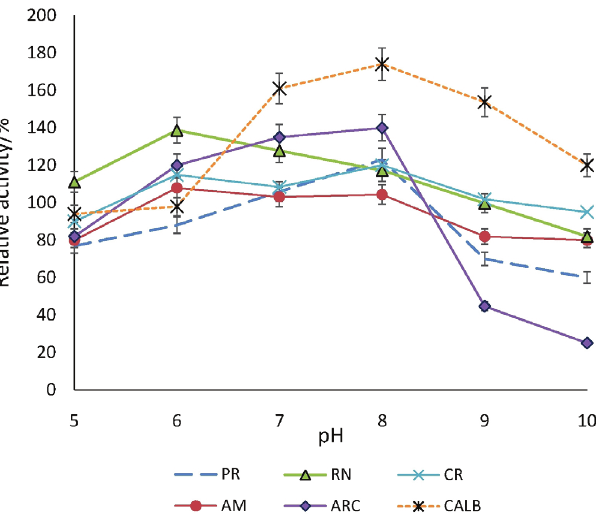
Fig. 3c – Stability of lipases at different pH values in the presence of NADES3 after 12 hours. 40 °C. Lipase from por- cine pancreas (PR), lipase from Candida rugosa (CR), Amano lipase PS, from Burkholderia cepacia (AM), lipase from Rhizo- pus niveus (RN), lipase acrylic resin from Candida antartica (ARC) (recombinant, expressed in Aspergillus niger), Lipase B Candida antartica immobilized on Immobead 150, recombinant from Aspergillus oryzae